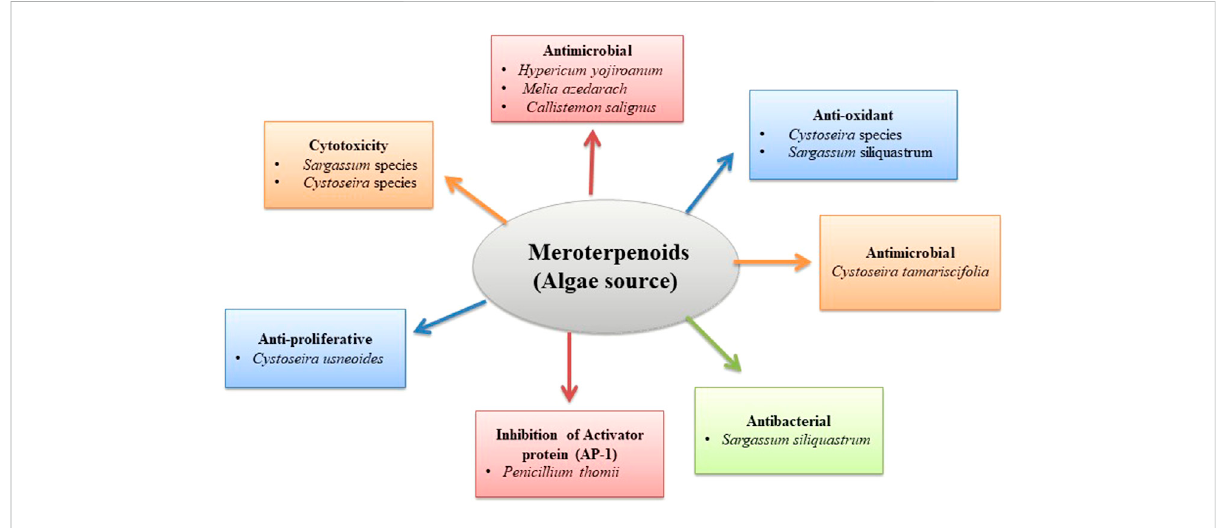
FIGURE 4 Biological activity of algae